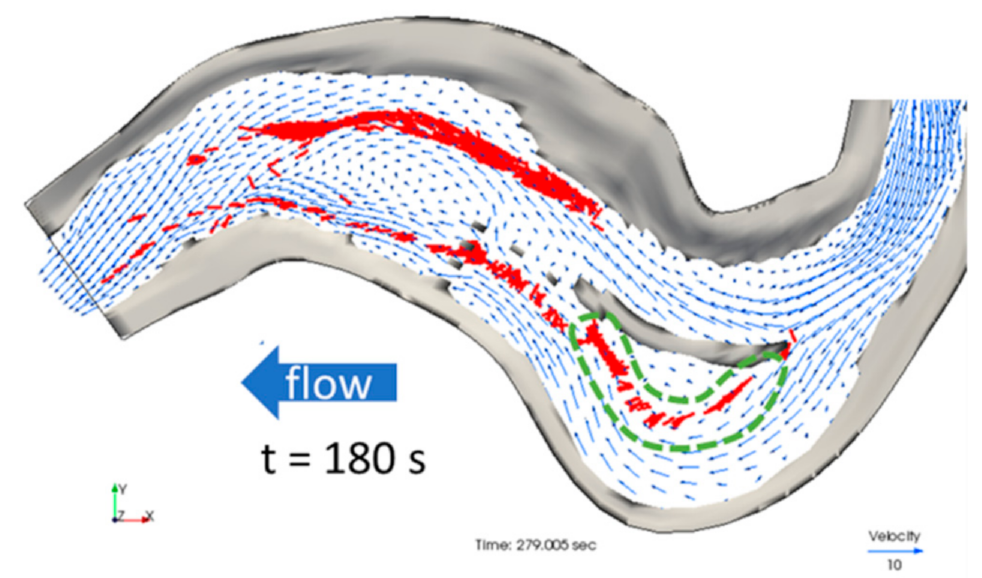
Figure 15. Plan view of the velocity vectors near the bottom and the driftwood distribution at t = 180 s (Run 1).